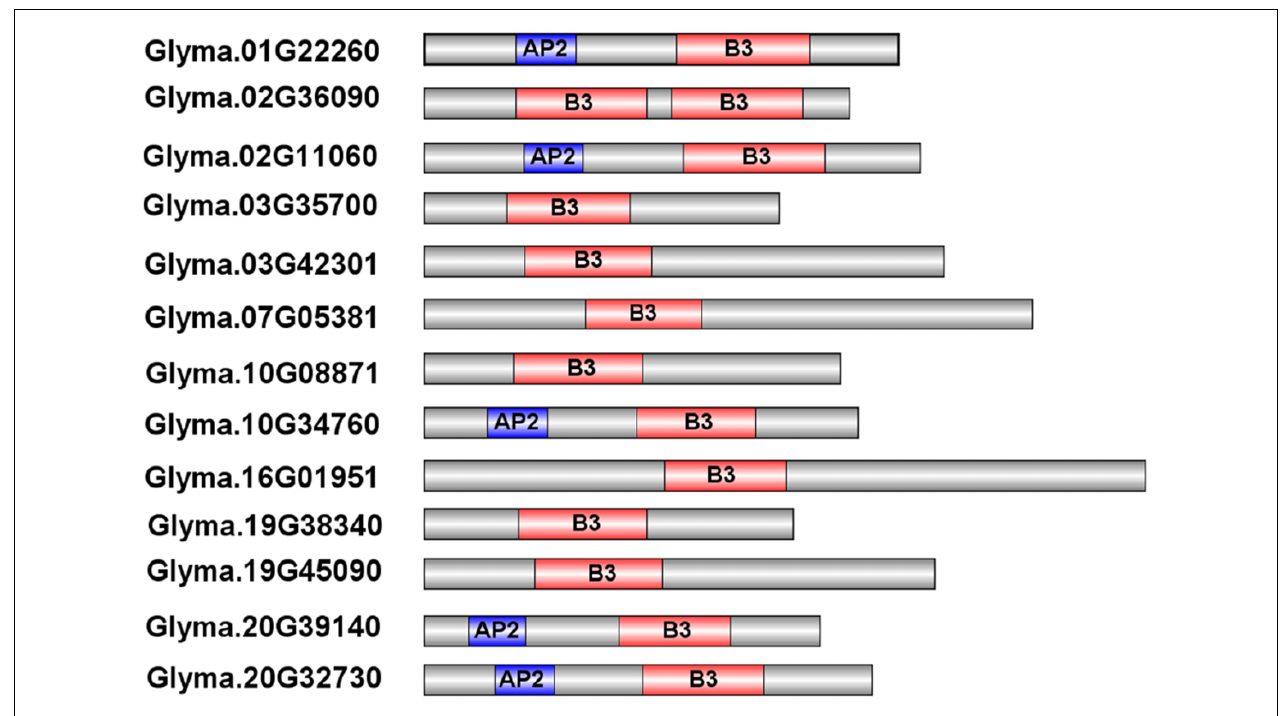
FIGURE 2 | Predicted structures of the RAV proteins in soybean. The B3 domains and AP2 domains are indicated by the red and blue boxes,